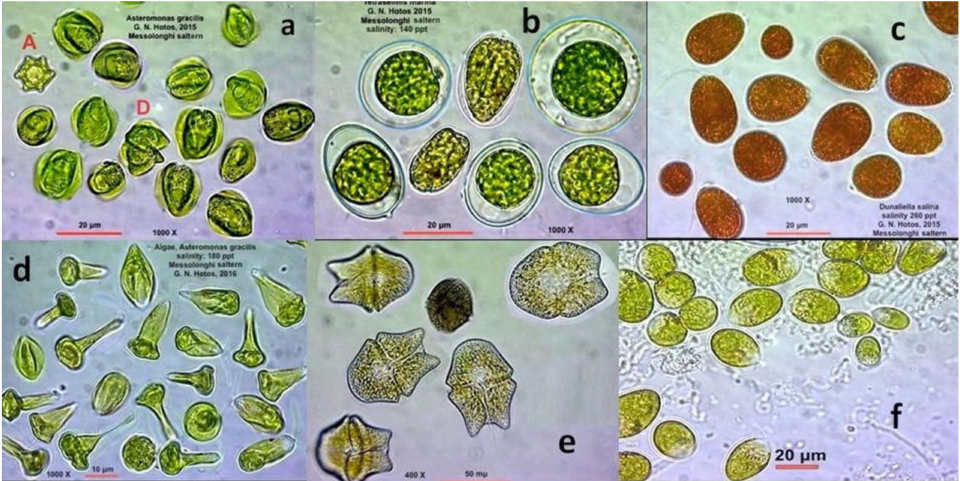
Figure 4. The dominant chlorophytes and dinophytes in hypersalinity. ( a ) Asteromonas gracilis ; ( b ) Tetraselmis marina , normal and palmelloid cells; ( c ) Dunaliella sp., reddish cells full of carotenoids at 180 ppt salinity; ( d ) Asteromonas gracilis in peculiar cell shapes; ( e ) the dinoflagellate Gymnodinium sp.; ( f ) Dunaliella sp., green cells at 100 ppt salinity.